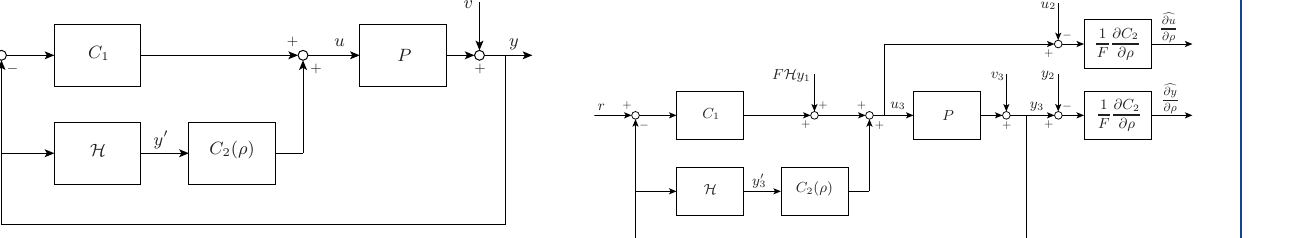
Figure 5. Block diagram of the gradient experiment for the multiple controller scenario. The controller C 1 is fixed and controller C 2 ( ρ ) y 1 ( k,ρ ), y 2 ( k,ρ ), and u 2 ( k,ρ ) are is subject to IFT. The signals H obtained from two other experiments and are required to obtain un- biased gradient